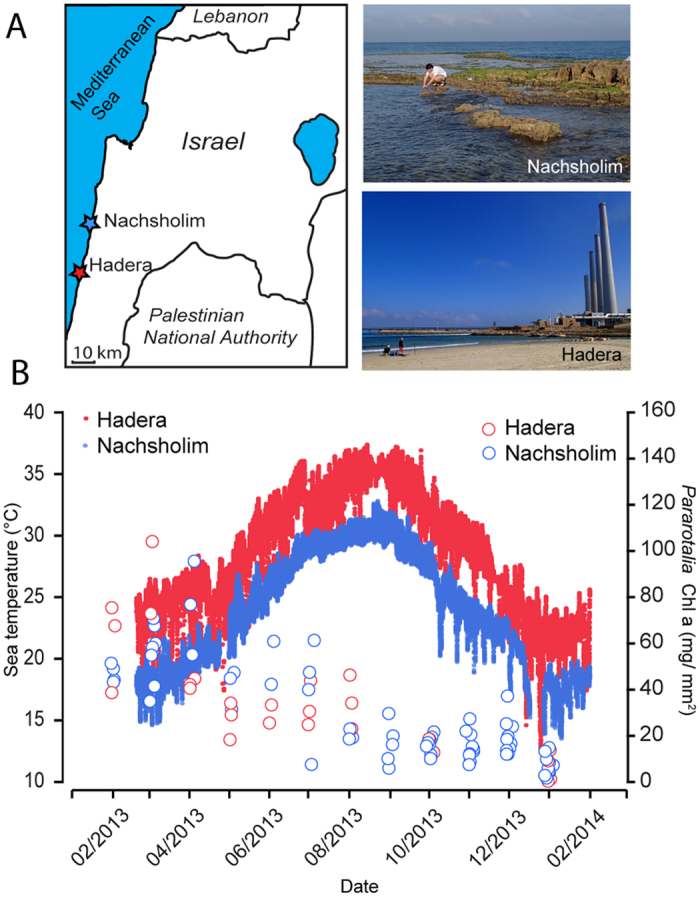
Illustration of the sampling area in the eastern Mediterranean and temperature logger data during the seasonal cycle of 2013.Figure 1A The Levantine Basin and the two sampling sites in this study: the heat-exposed site (Hadera) where cooling water raises locally ambient sea water temperatures, and the control site (Nachsholim) towards the north, Map was created in Adobe Illustrator software re-drawn after OpenStreetMap, Fig. 1B Sea water temperature (dots) measured by loggers at these sites (~0.5 m) during 2013 annual cycle44 (left) and chlorophyll a pigment data (mg/mm2 surface area) measured in the foraminifera Pararotalia calcariformata collected from these locations (circles).